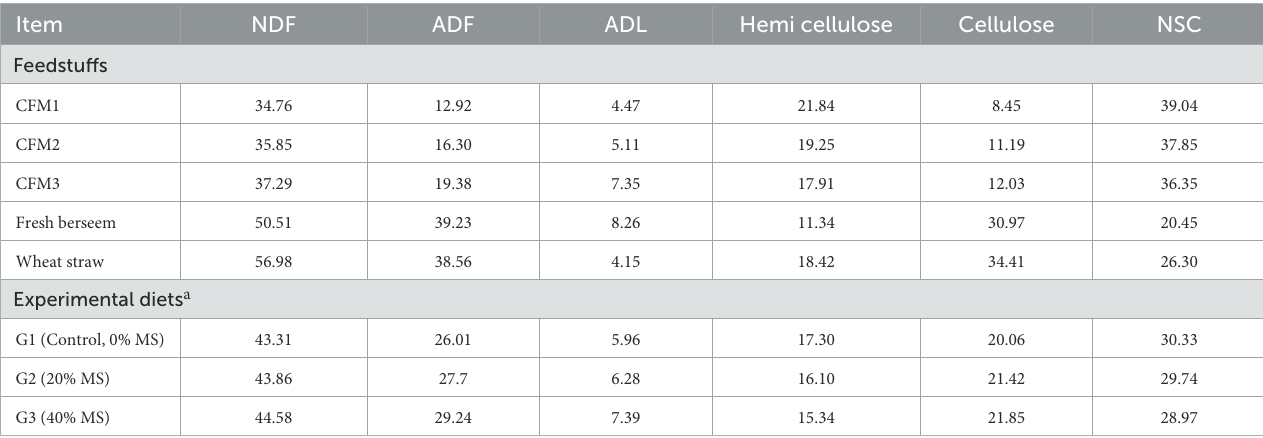
CFM ingredients and feedstuffs Yellow corn grains